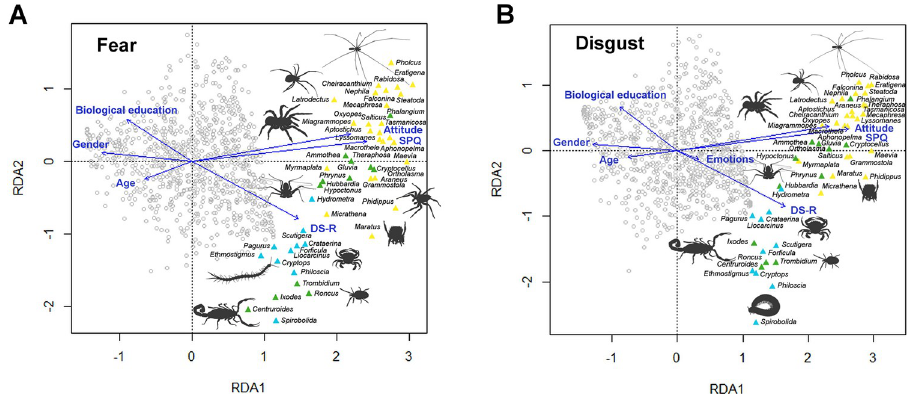
Fig 4. Results of the RDA analysis for fear (A) and disgust (B) scores. Spider stimuli are in yellow, other chelicerates in green, and other arthropods in blue; grey circles stand for respondents. Blue arrows represent variables entered the analysis (“Attitude” for the attitude toward spiders; “Emotions” for the first rated emotion).